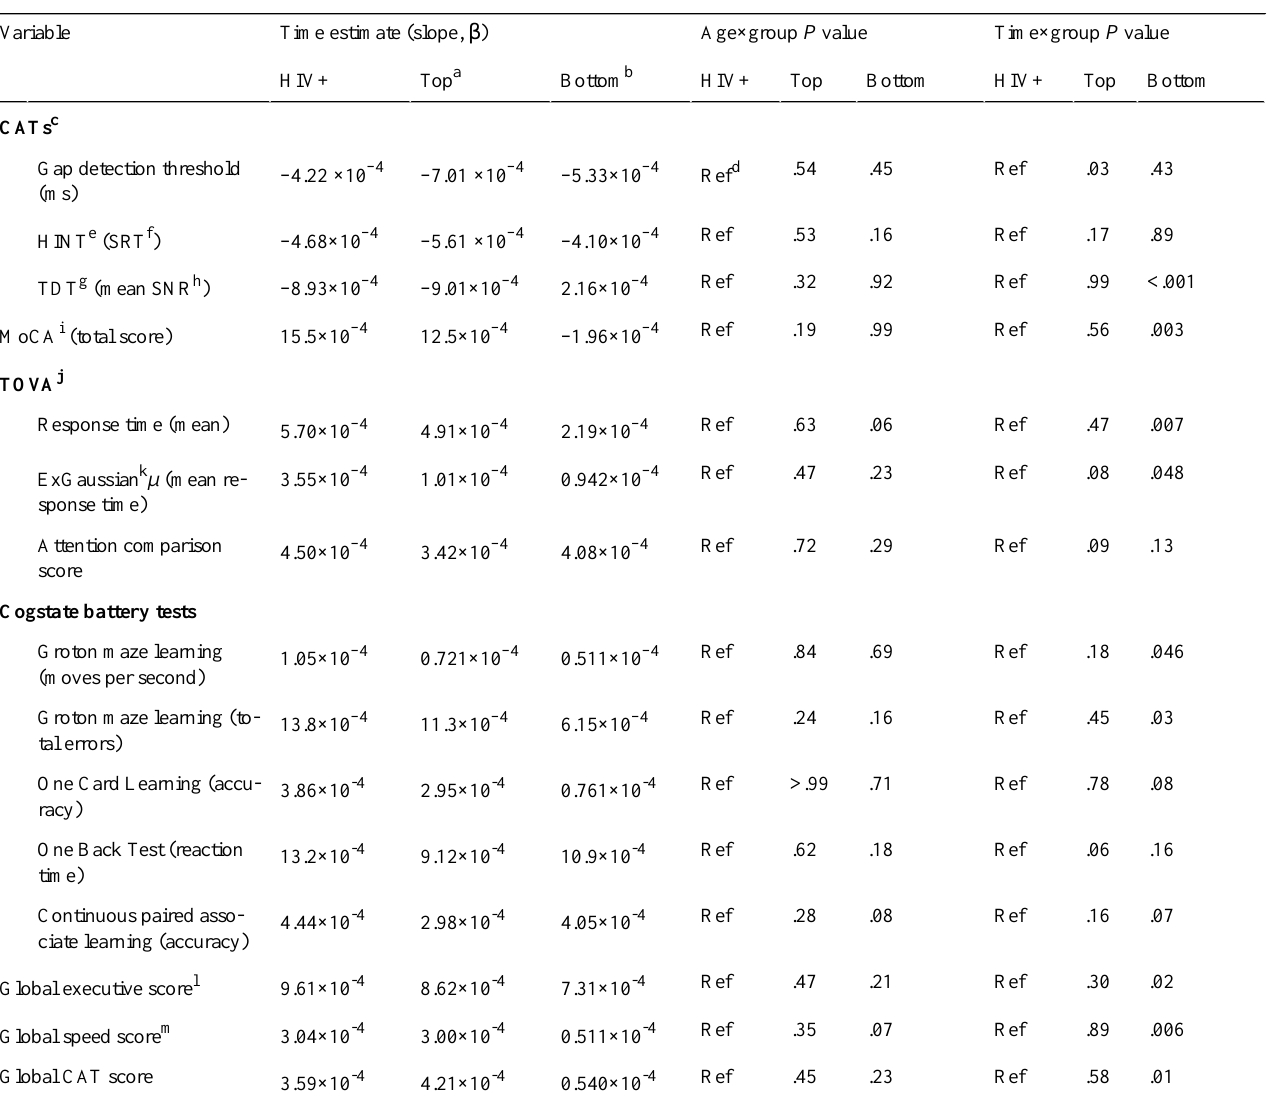
Table 2. Results of linear mixed effect